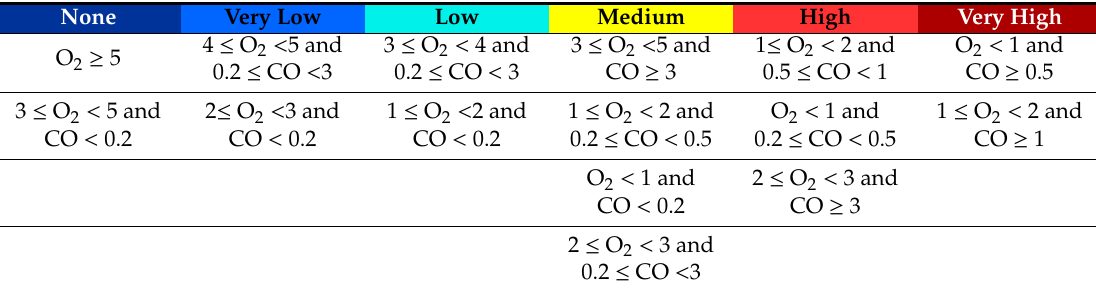
Table 2. The assumed criteria for danger of low-emission corrosion estimation (O 2 and CO in %). None Very Low Low Medium High Very High 4 ≤ O 2 < 5 and 3 ≤ O 2 < 4 and 3 ≤ O 2 < 5 and 1 ≤ O 2 < 2 and O 2 < 1 and O 2 ≥ 5 0.2 ≤ CO < 3 0.2 ≤ CO < 3 CO ≥ 3 0.5 ≤ CO < 1 CO ≥ 0.5 3 ≤ O 2 < 5